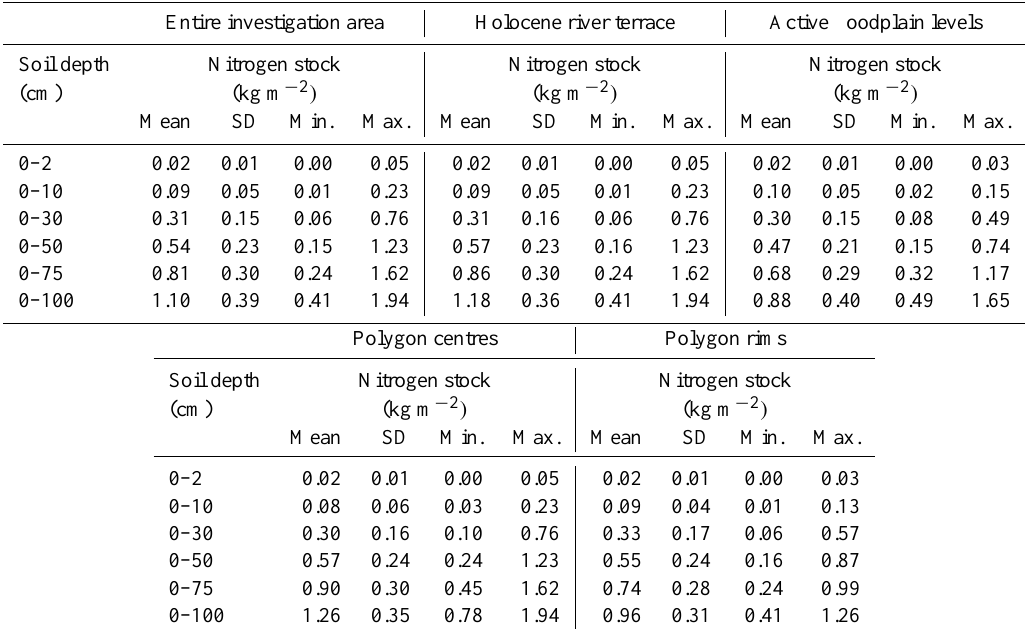
Table 5. The nitrogen stocks. The results are expressed in kg m − 2 with the mean values and the respective standard deviations as well as the minima and